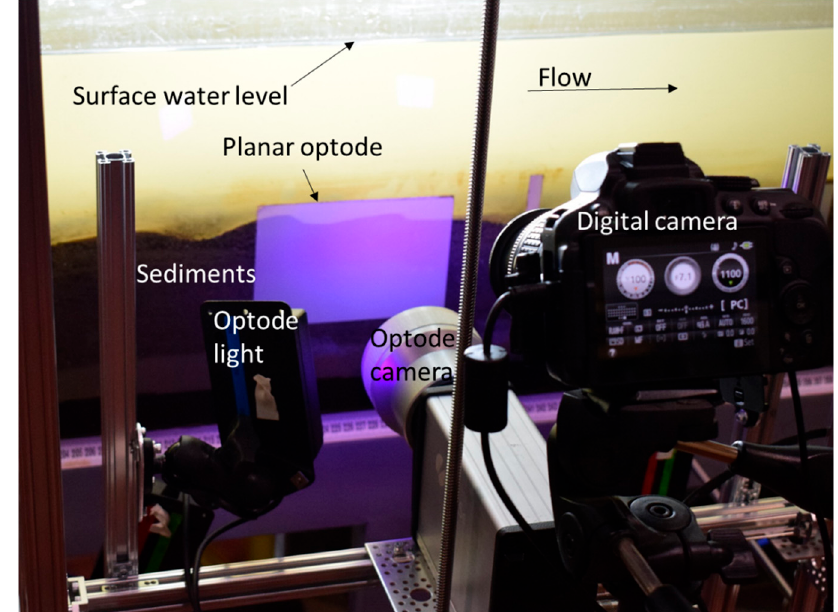
Figure A1. Experimental set-up of the planar optodes.